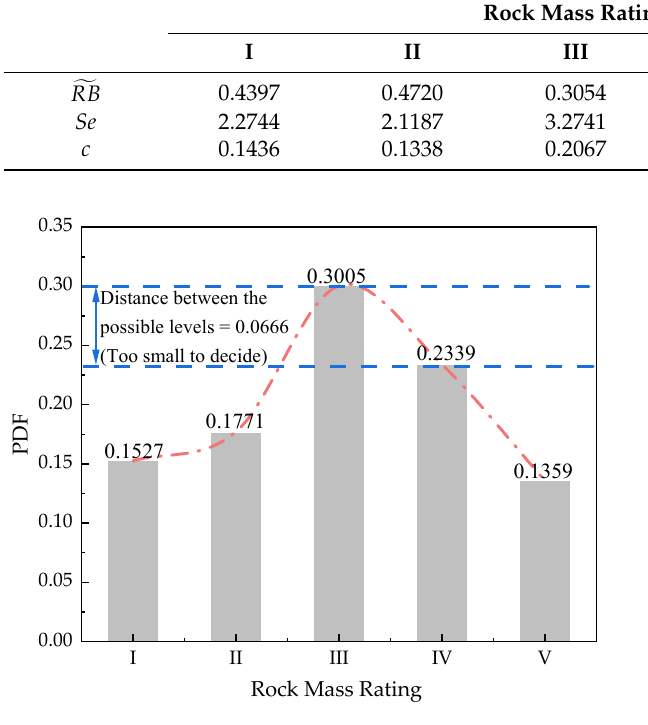
Figure 3. BPAs of each dataset as evidence. Table 4. Fusion process of the model validation.